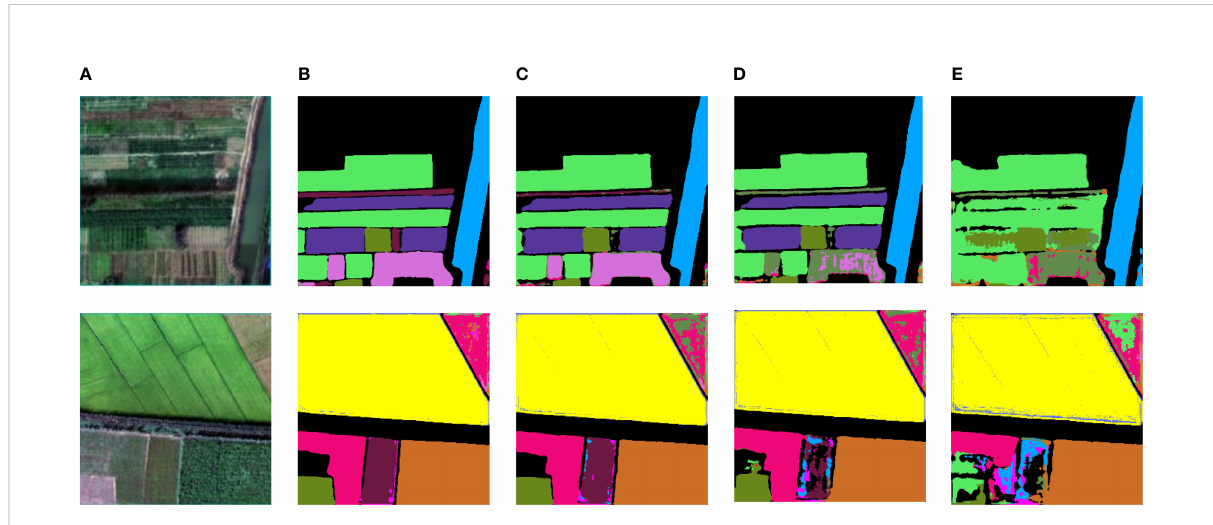
FIGURE 10 Training results of different multi-source data superposition on the improved U-NET: (A) Original spectral image; (B) PCA; (C) PCA+NDVI; (D) PCA+NDVI+Sobel; (E) PCA+NDVI+Sobel+GLCM.